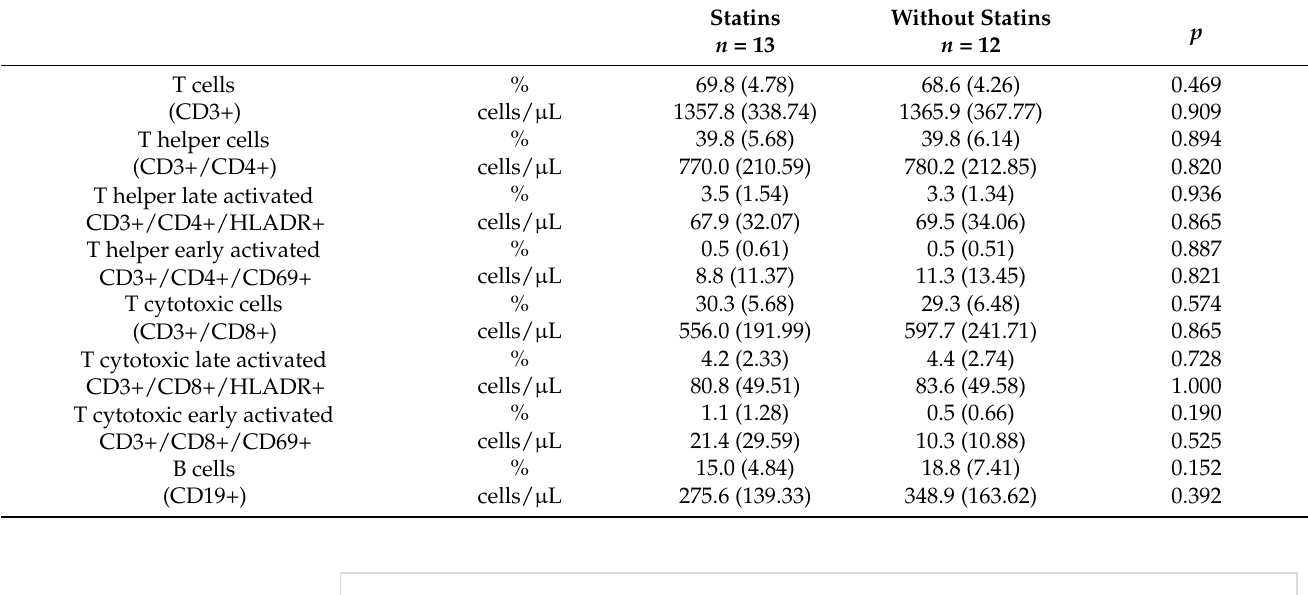
Table 3. Main subpopulations of peripheral blood lymphocytes in studied participants. The data are presented as a percentage of receptor-bearing cells and the absolute cell numbers. Mean values and standard deviations (in brackets) are shown. Mann–Whitney two-sided rank U-test was used.